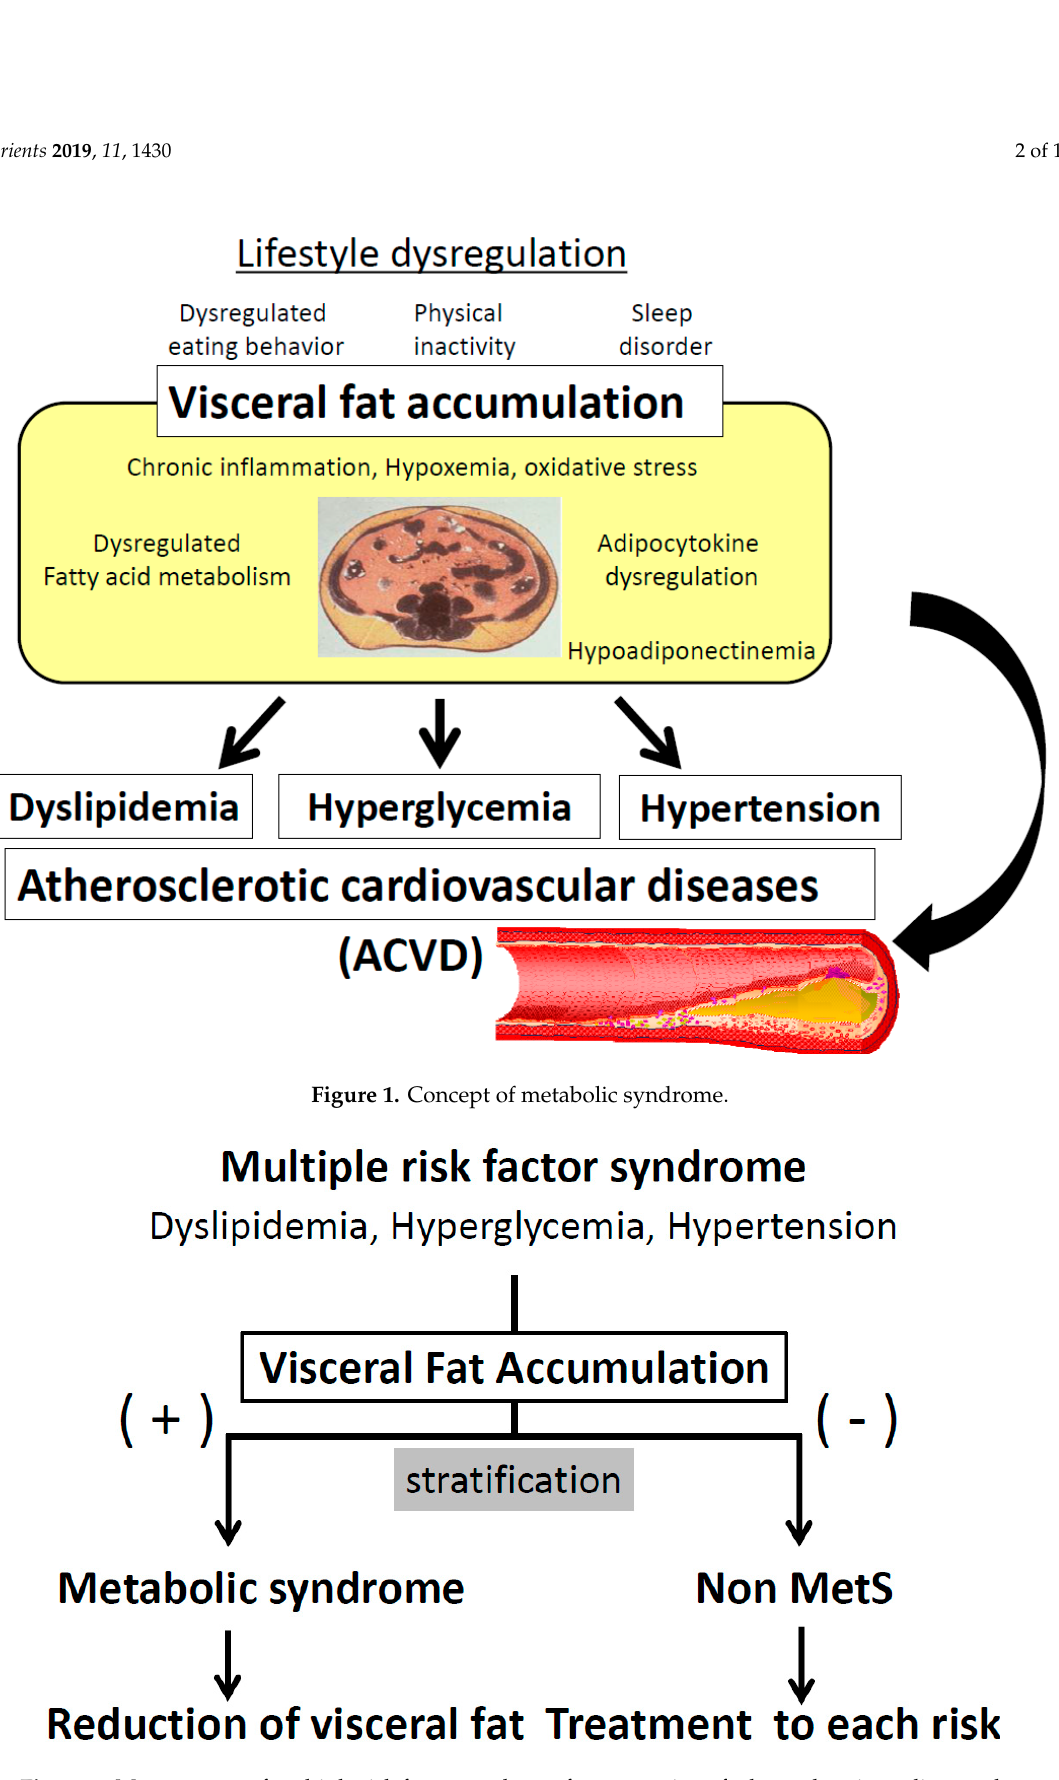
Figure 2. Management of multiple risk factor syndrome for prevention of atherosclerotic cardiovascular diseases (ACVD); “Metabolic syndrome (Mets)-oriented approach”.